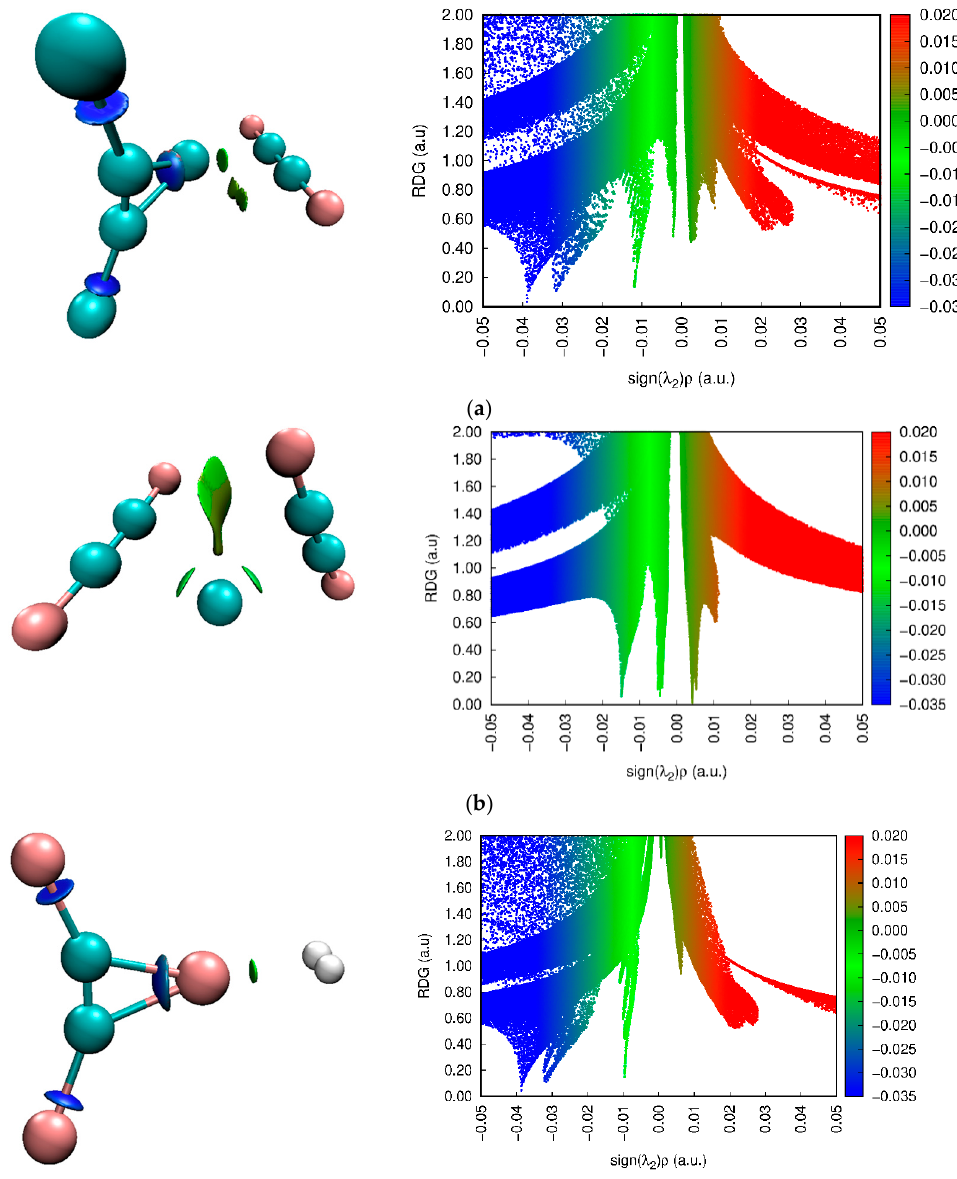
Figure 5. The RDG plots ( right ) and the corresponding molecular systems ( left ) of selected lithi ‐ um ‐ bound complexes. The following complexes are presented: ( a ) C 2 Li 3+ ‐ C 2 F 2 , ( b ) C 2 F 2 Li + ‐ C 2 F 2 , ( c ) bound complexes. The following complexes are presented: ( a ) C 2 Li 3+ -C 2 F 2 , ( b ) C 2 F 2 Li + -C 2 F 2 , C 2 Li 3+ ‐ H 2 . ( c ) C 2 Li 3+ -H 2